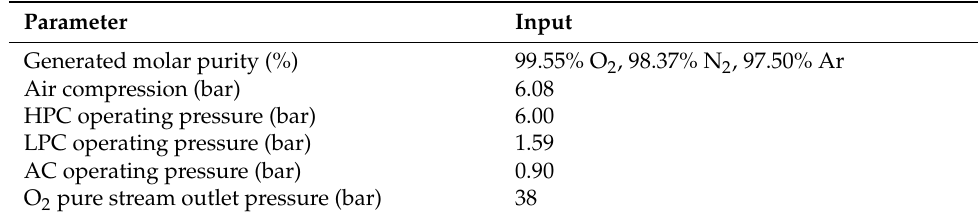
Table 4. Air separation unit process parameters.